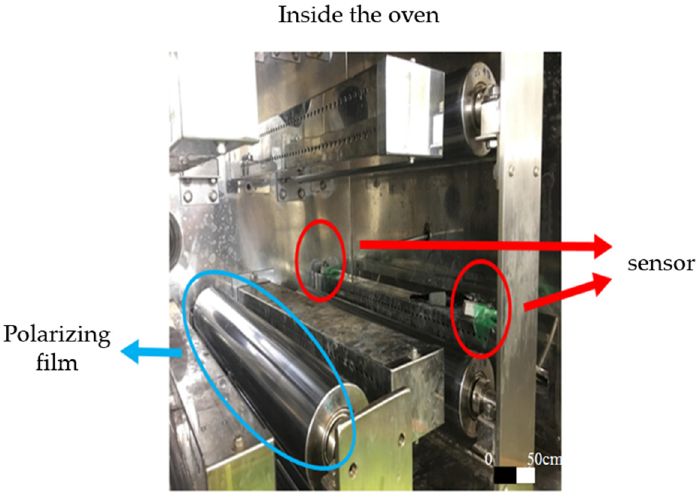
Figure 9. Setting up a flexible three-in-one microsensor in the laboratory oven.